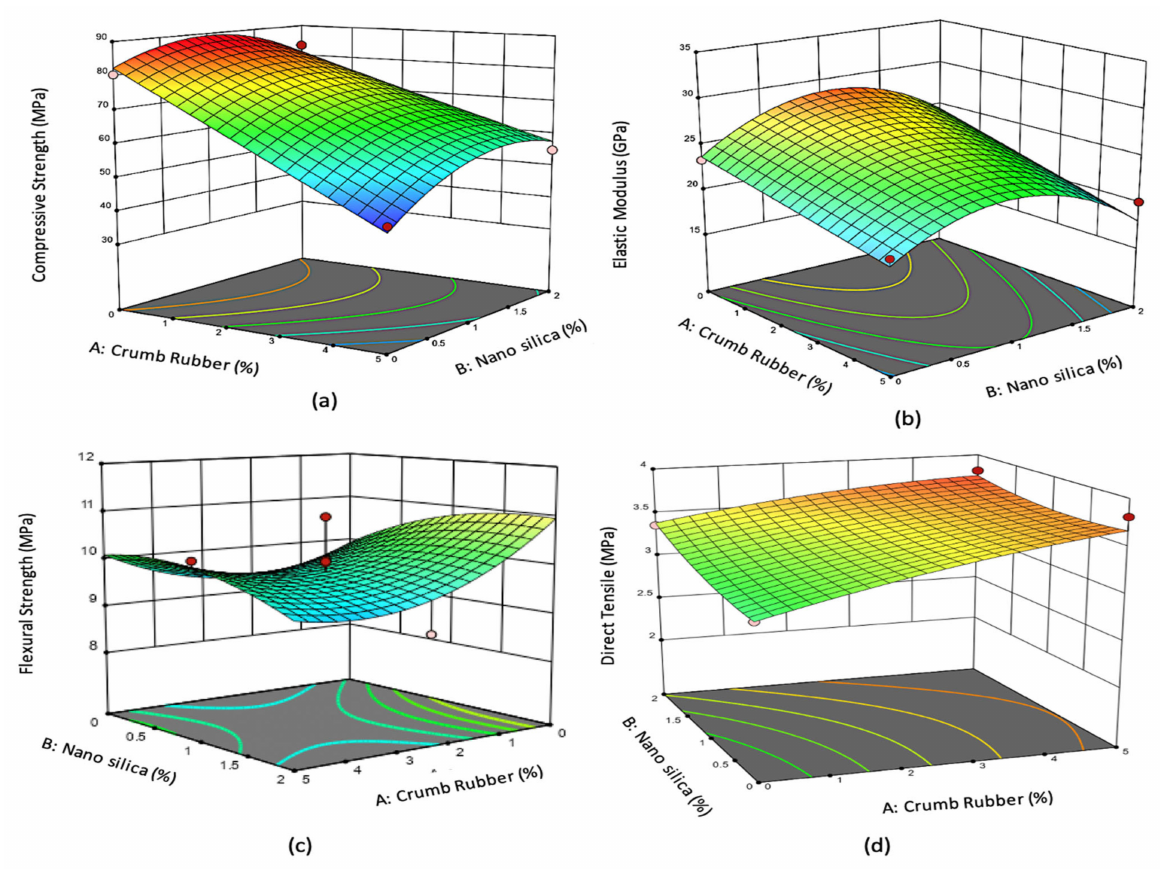
Figure 7. The 3D response surface plot for 50% fly ash and 2% PVA fiber for ( a ) compressive strength, ( b ) flexural strength, ( c ) direct tensile strength, and ( d ) elastic